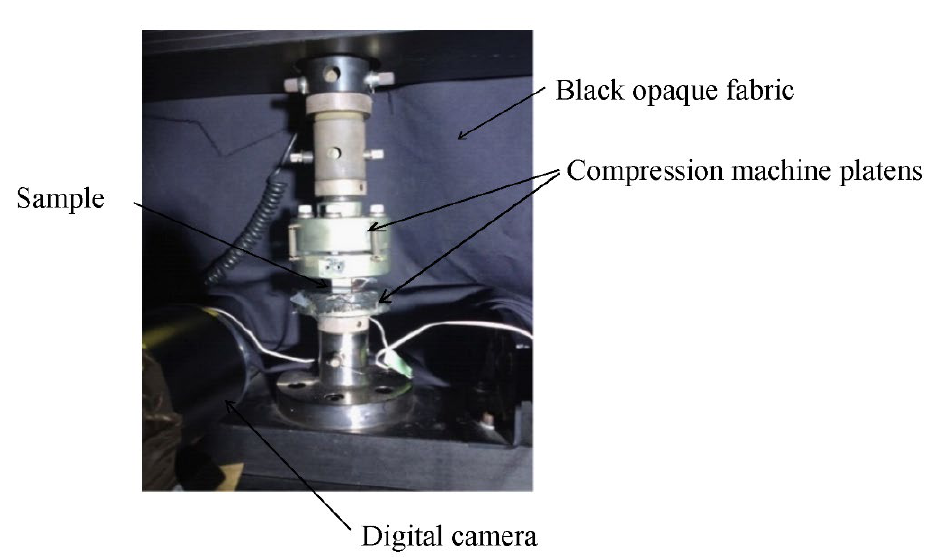
Figure 1. Compression test set-up.